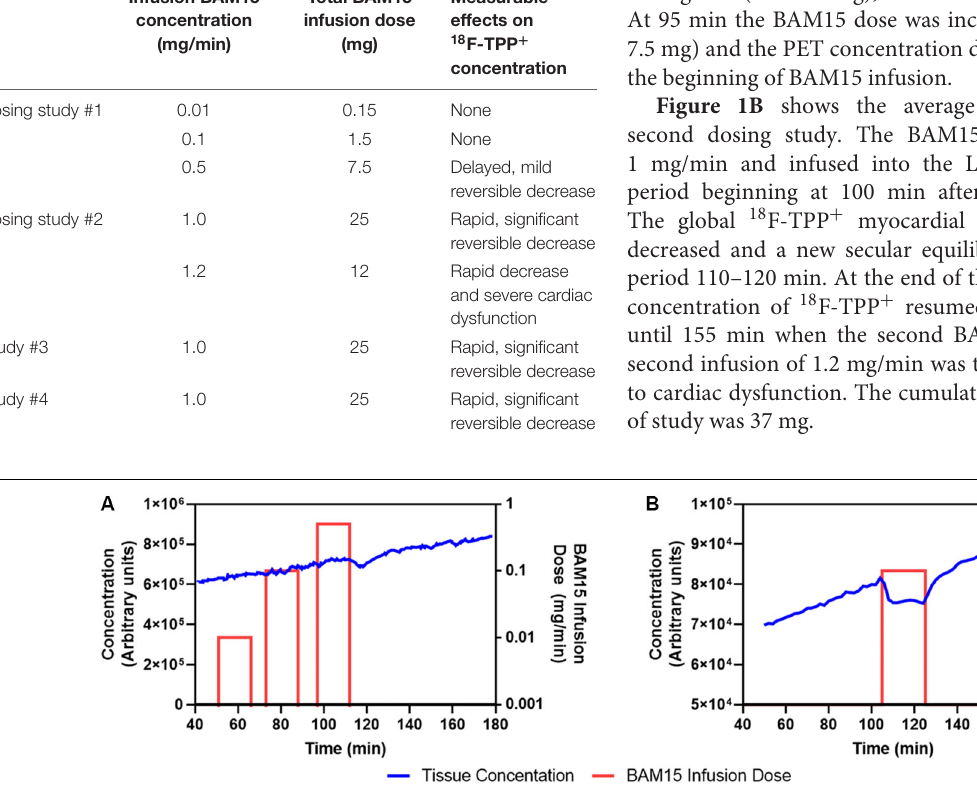
FIGURE 1 | First (A) and second (B) BAM15 dosing study. Blue line denotes PET average concentration measurements of 18 F-TPP + in myocardium. The red bars indicate periods of BAM15 intracoronary infusion. The height of the bar is proportional to the BAM15 dose rate and is keyed to the dose rate scale on the right side of the graph. Cumulative BAM15 dose is obtained by multiplying the dose rate by the infusion time. A putative dose response is noted beginning at about 115 min in A; whereas, B suggests that the BAM15 infusion causes depolarization of mitochondria during the period 110–125 min. After the first BAM15 infusion was stopped, the 18 F-TPP + concentration resumed is original